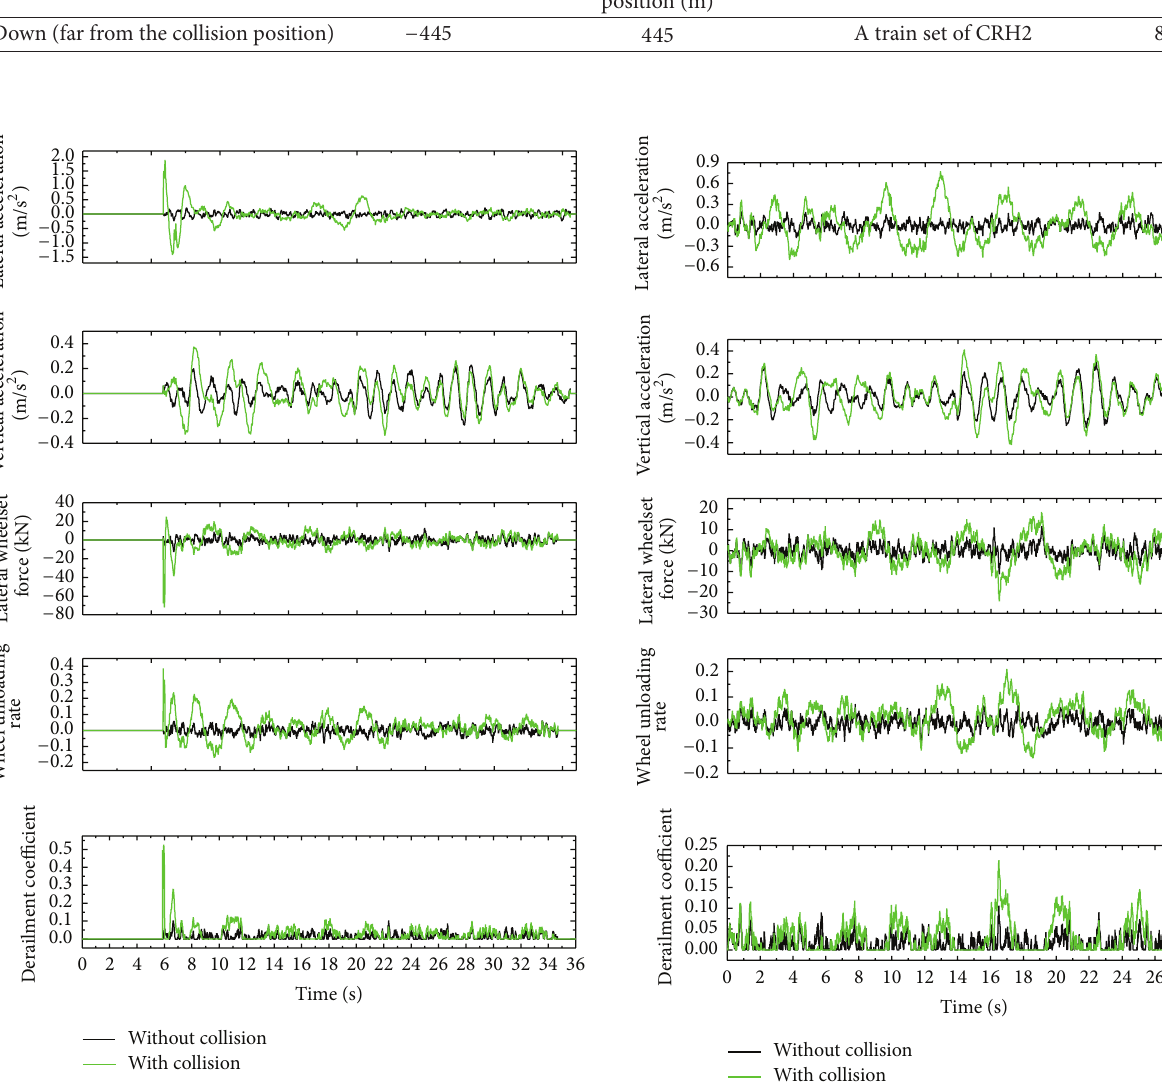
Figure 15: Responses of the trailer (the first train, 𝑋 2 = − 445 m, 80 km/h, in the down